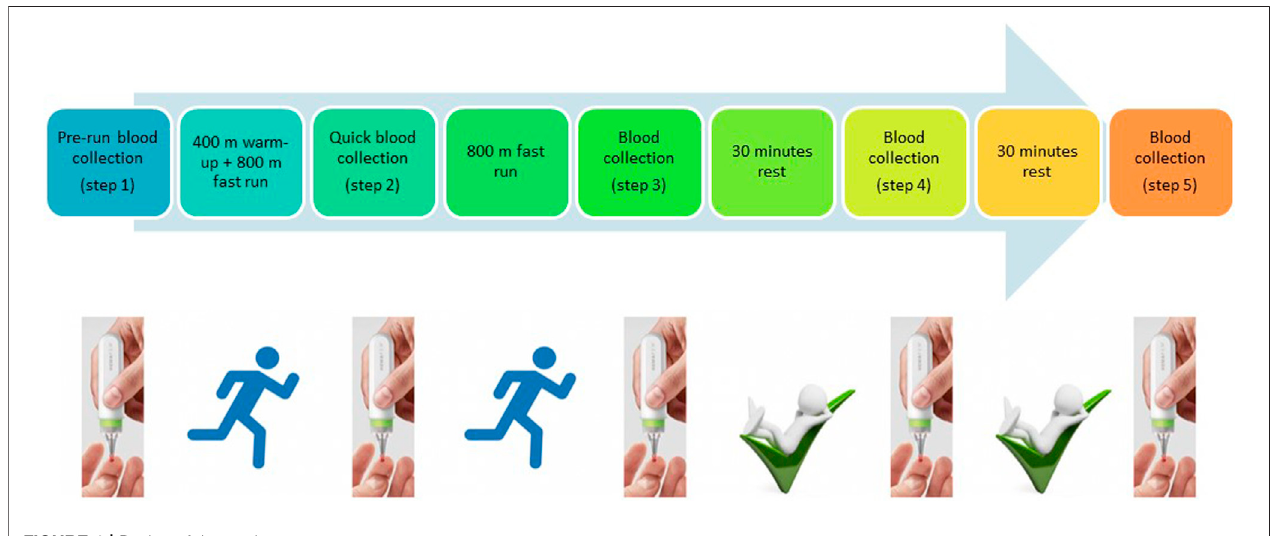
FIGURE 1 | Design of the